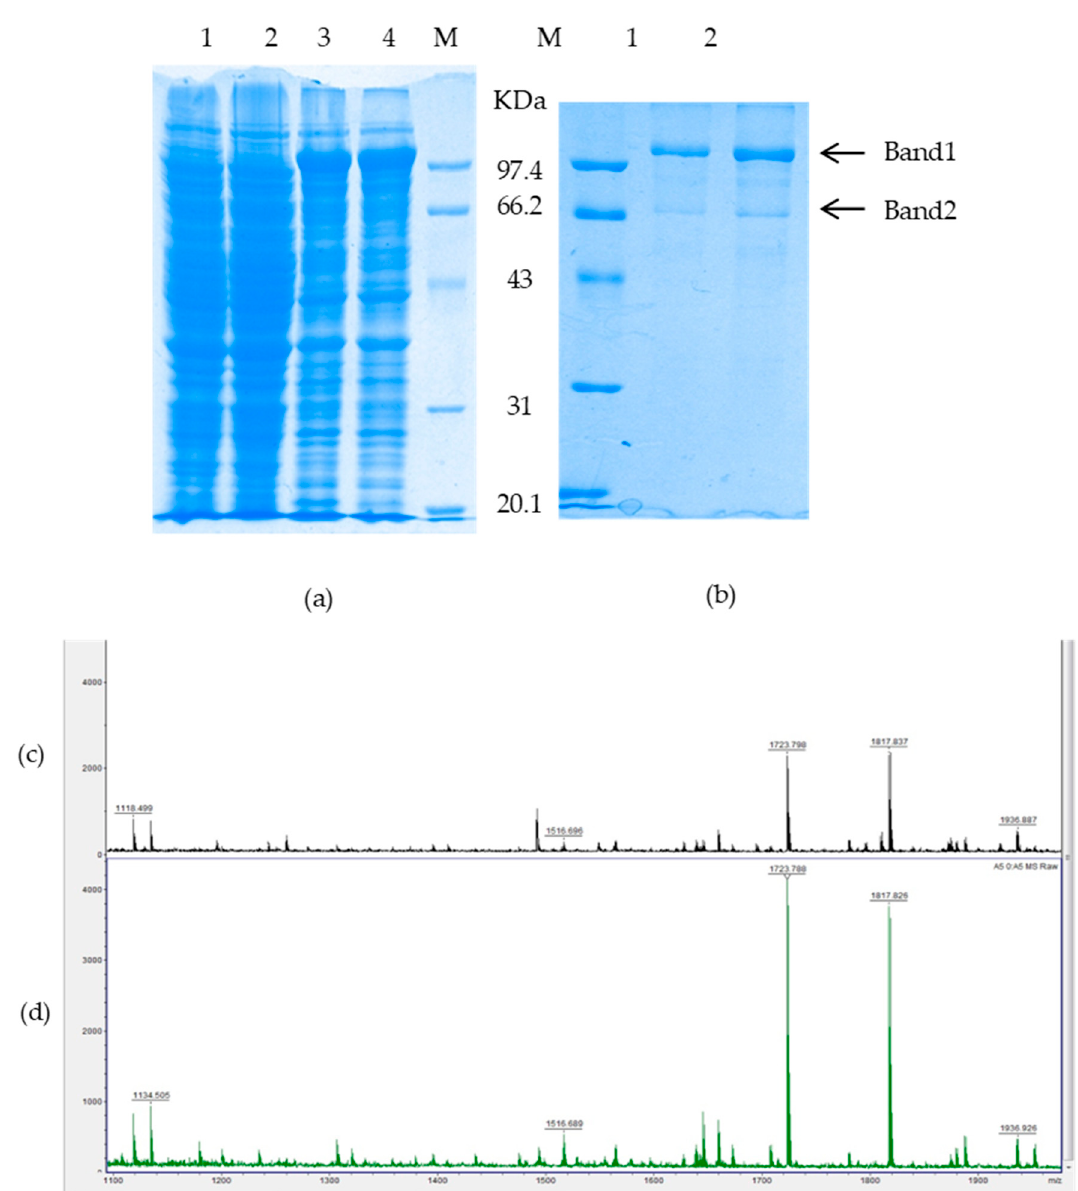
Figure A1. The expression, purification and identification of recombinant lamprey Vav3 his-tag fusion protein. A pET-32a (+) vector was used as the expression vector for expressing lamprey Vav3 open reading frame (ORF) region in Escherichia coli BL21 (DE3) as a fusion protein with 6× His-tag. The recombinant lamprey Vav3 was separated by 12% SDS-PAGE and stained with coomassie brilliant blue R-250. ( a ) The recombinant lamprey Vav3 was overexpressed in E. coli BL21 (DE3) strain by 1 and 0.1 mM IPTG induction. M: protein marker; 1: crude lysate of E. Coli BL21 (DE3) transformed by pET-32a (+) vector with 1mM IPTG induction; 2: crude lysate of E. Coli BL21 transformed by pET-32a (+lamprey Vav3) vector without IPTG induction; 3: crude lysate of E. Coli BL21 transformed by pET-32a (+lamprey Vav3) vector with 1mM IPTG induction; 4: crude lysate of E. Coli BL21 transformed by pET-32a (+lamprey Vav3) vector with 0.1mM IPTG induction; ( b ) The recombinant lamprey Vav3 his-tag fusion protein was purified by using affinity chromatography method with Ni-NTA His-Bind ® Resin. M: protein marker; 1: target protein eluted with 25 mM imidazole elution buffer; 2: target protein eluted by 100 mM imidazole elution buffer; ( c , d ) Peptide mass fingerprinting analysis of recombinant lamprey Vav3 protein bands 1 and 2 by an autoflex™ speed MALDI-TOF mass spectrometer.